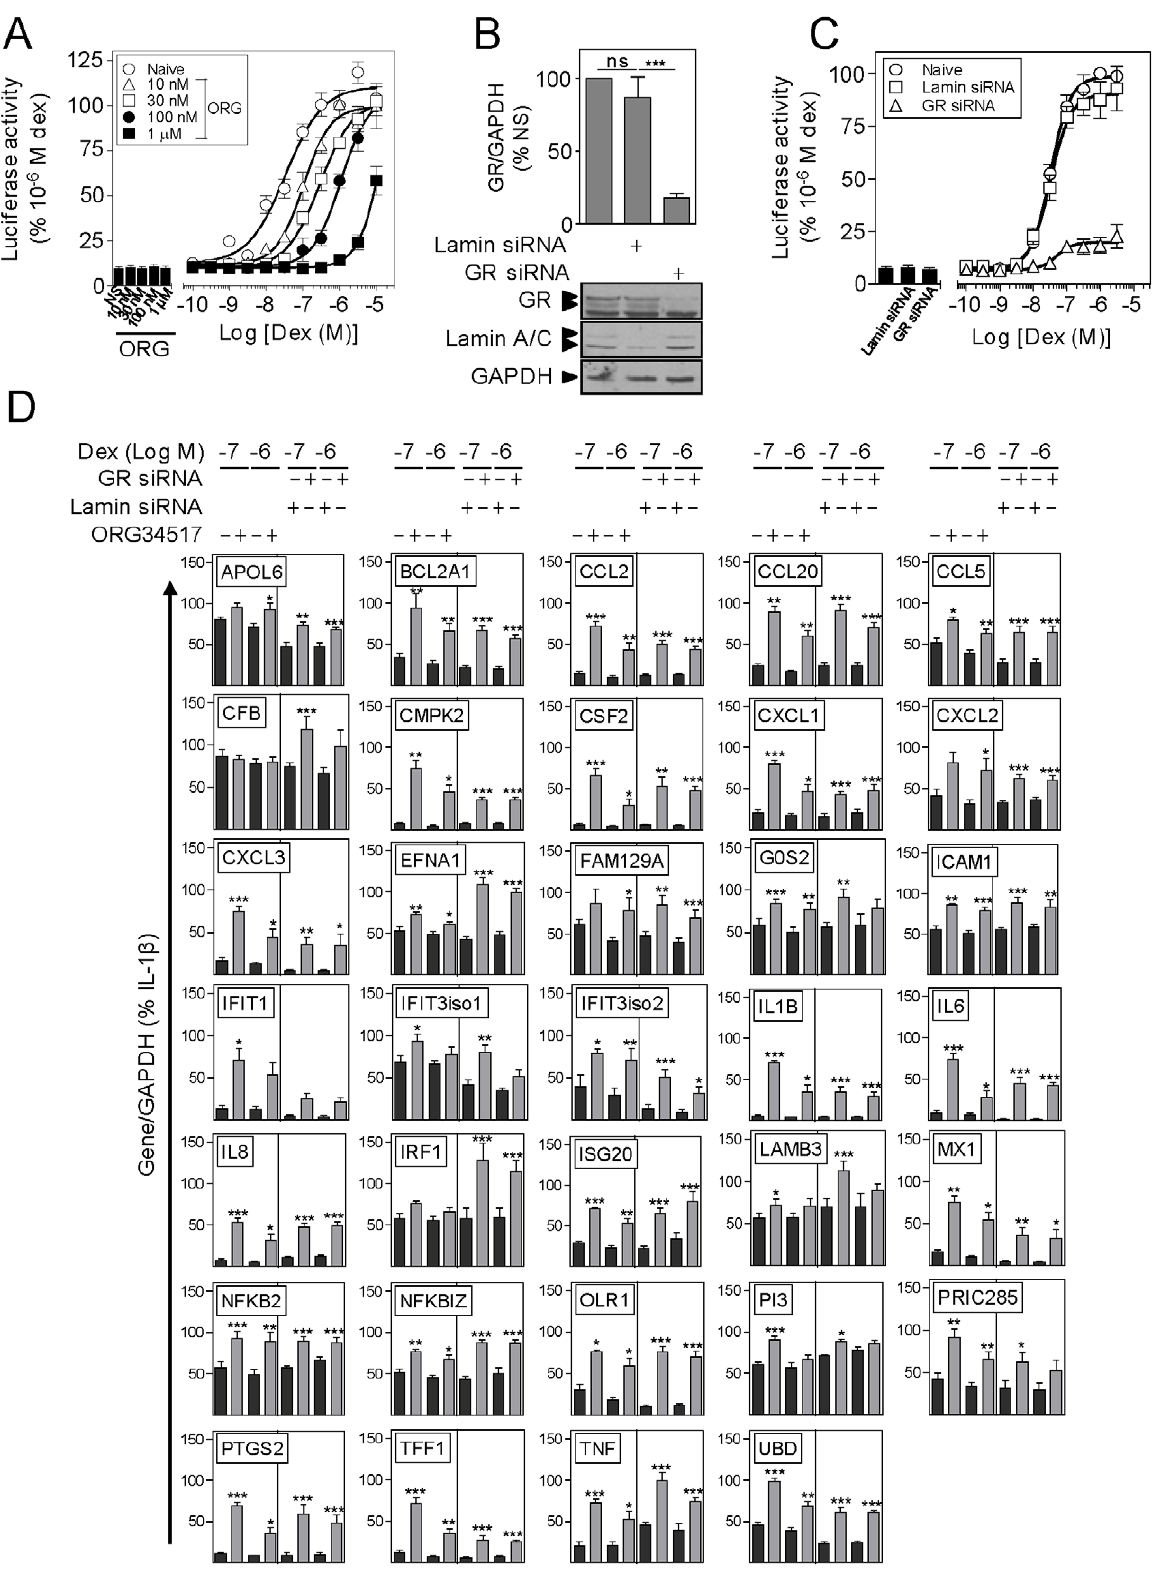
Figure 3. Effect of ORG34517 and GR-specific siRNA on repression of inflammatory gene expression by dexamethasone. A. A549 cells stably transfected with a 2 6 GRE reporter were incubated with the indicated concentrations of ORG34517 for 30 min prior to stimulation with increasing concentrations of dexamethasone (Dex) as indicated for 6 h. Cells were then harvested for luciferase assay. Data (n=4–5) are expressed as a percentage of 1 m M dexamethasone and plotted as means 6 SE. B. A549 cells were incubated with either lamin- (control) or GR-specific siRNA for